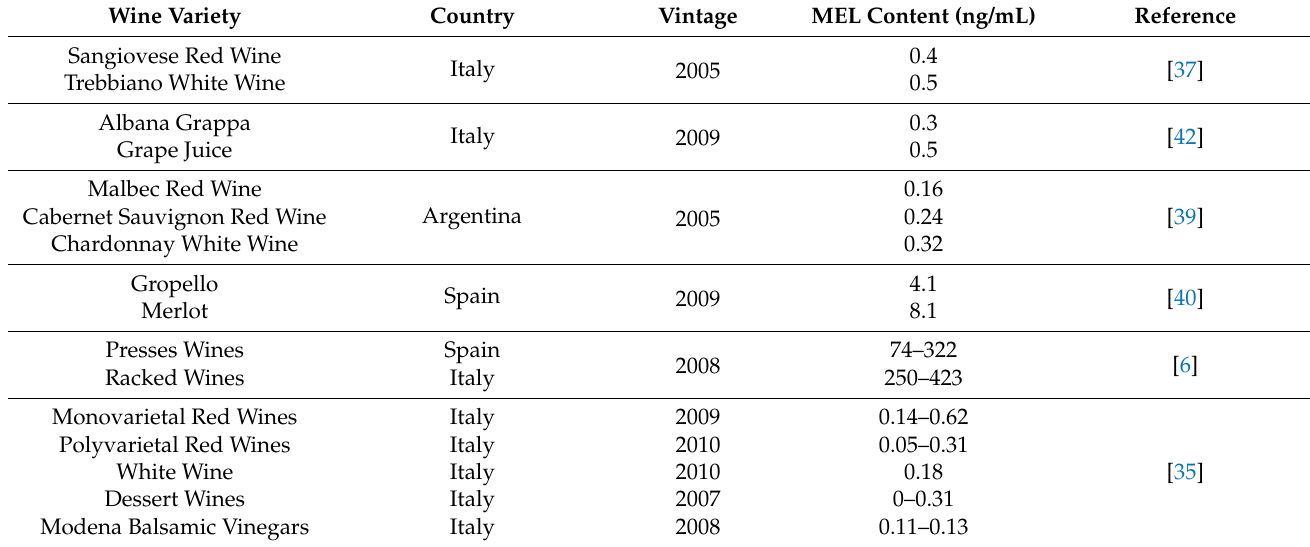
Table 1. MEL content in different types of wines depending on grape variety, country and harvest. Adapted from Meng et al.